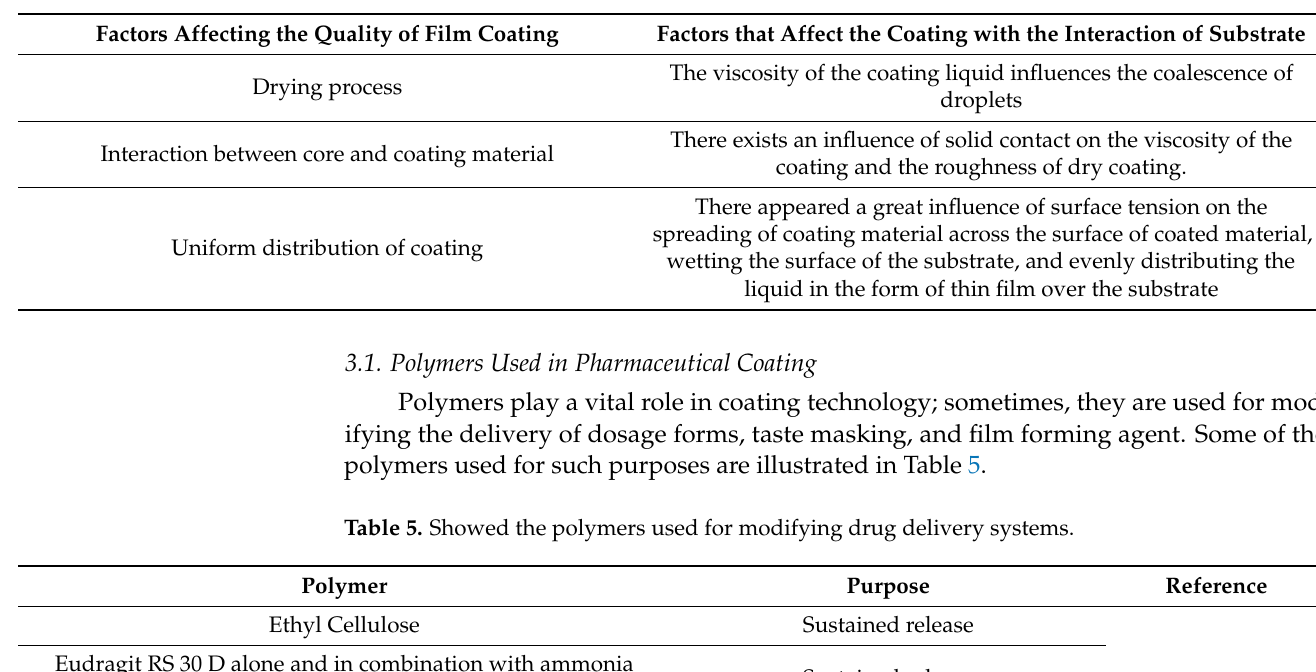
Table 4. Factors that affect the quality of film coating [31].